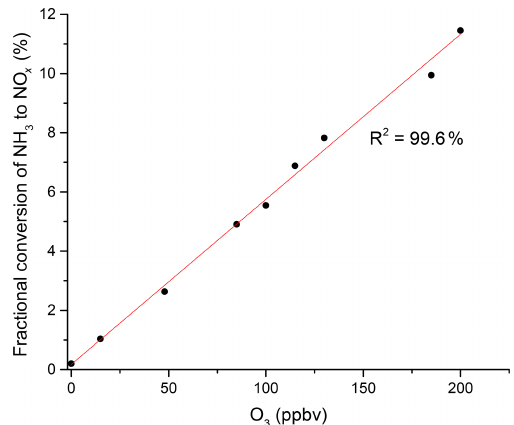
Figure 3. NH 3 to NO x conversion in the heated inlet channel of the instrument in the presence of O 3 . The fractional conversion of NH 3 to NO x is calculated from the 13.1ppmv of NH 3 from the permeation